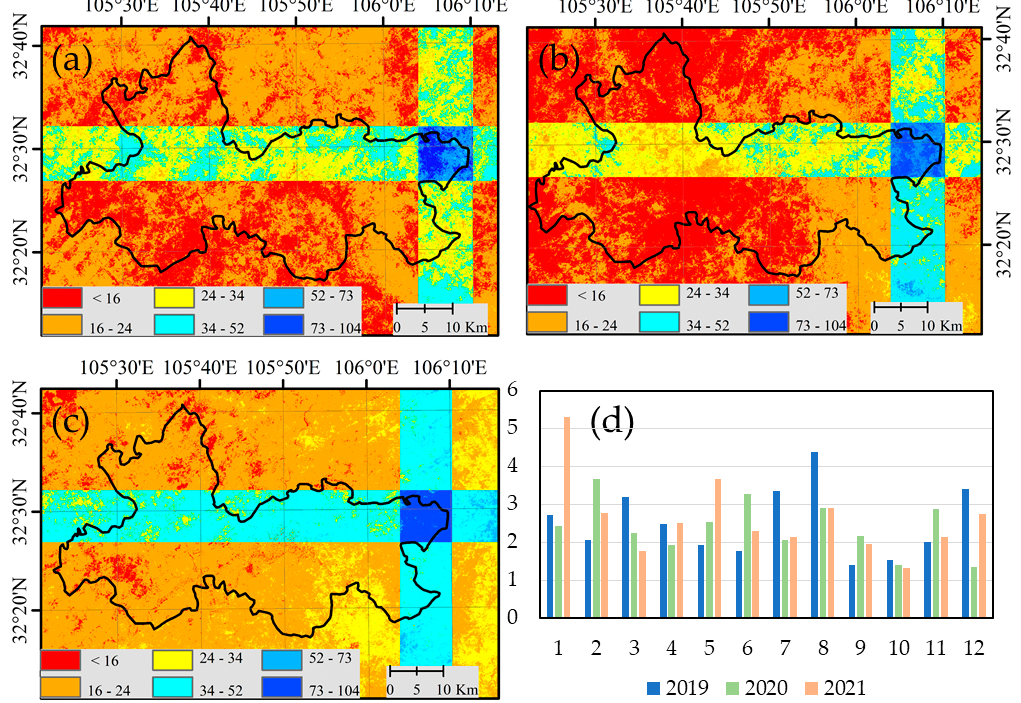
Figure 3. The numbers of cloudless pixels of Sentinel-2 image in the study area from 2019 to 2021. ( a – c ) The numbers of cloudless pixels in 2019 to 2021, respectively. ( d ) The monthly numbers of cloudless pixels from 2019 to 2021.